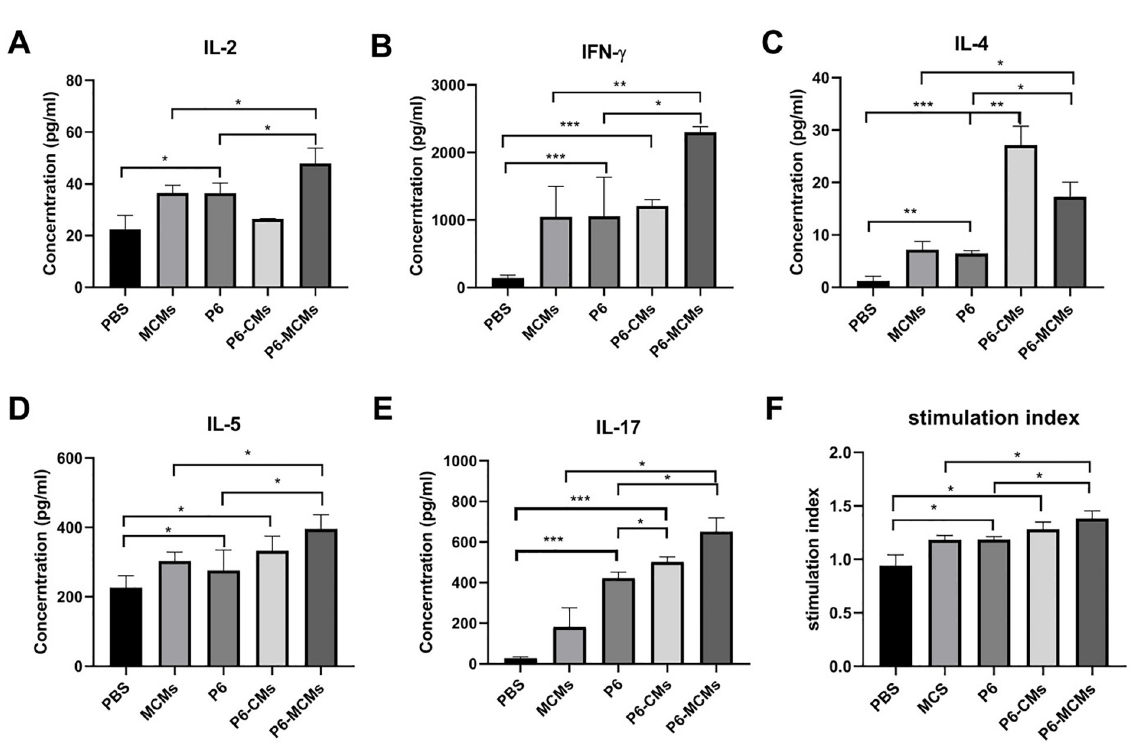
Fig 5. Analysis of cytokine levels in spleen lymphocyte culture supernatants and T lymphocyte proliferation assays. The levels of IL-2 ( A ), IFN- γ ( B ), IL-4 ( C ), IL-5 ( D ), and IL-17 ( E ) in lymphocyte culture supernatants. ( F ) Stimulation index of spleen lymphocytes determined according to the absorbance at 450 nm of the stimulated group and the control group. Values are the mean ± SD, n = 3. Significant differences were expressed as � P < 0.05, �� P < 0.01, ��� P < 0.001.